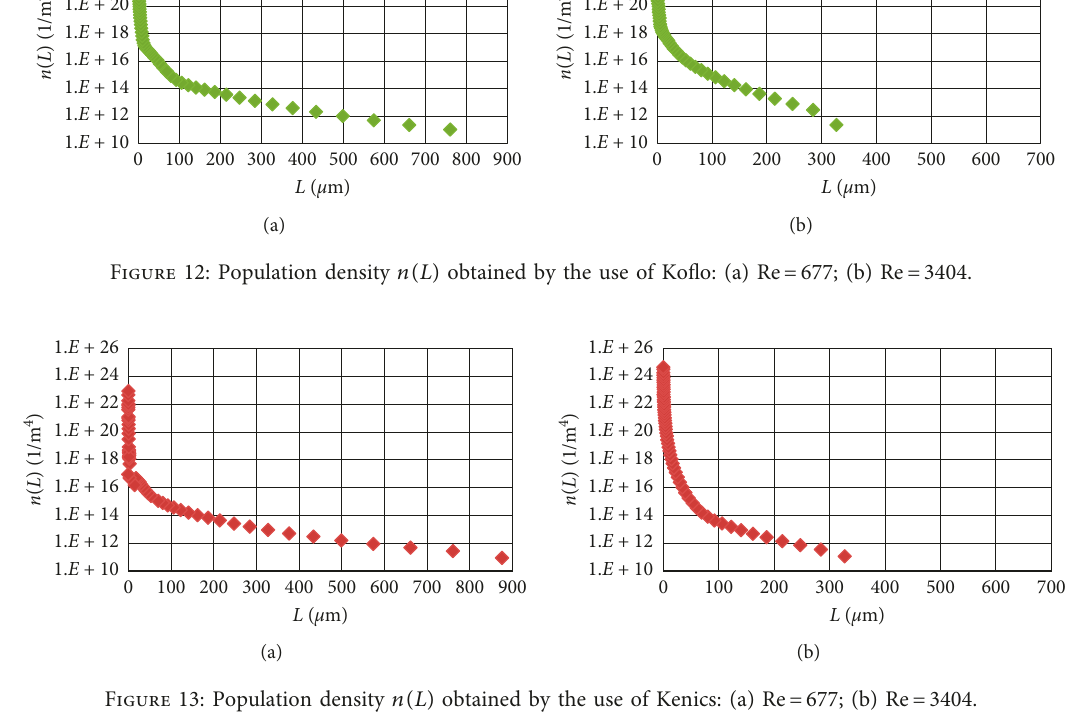
677; (b) Re (cid:31)